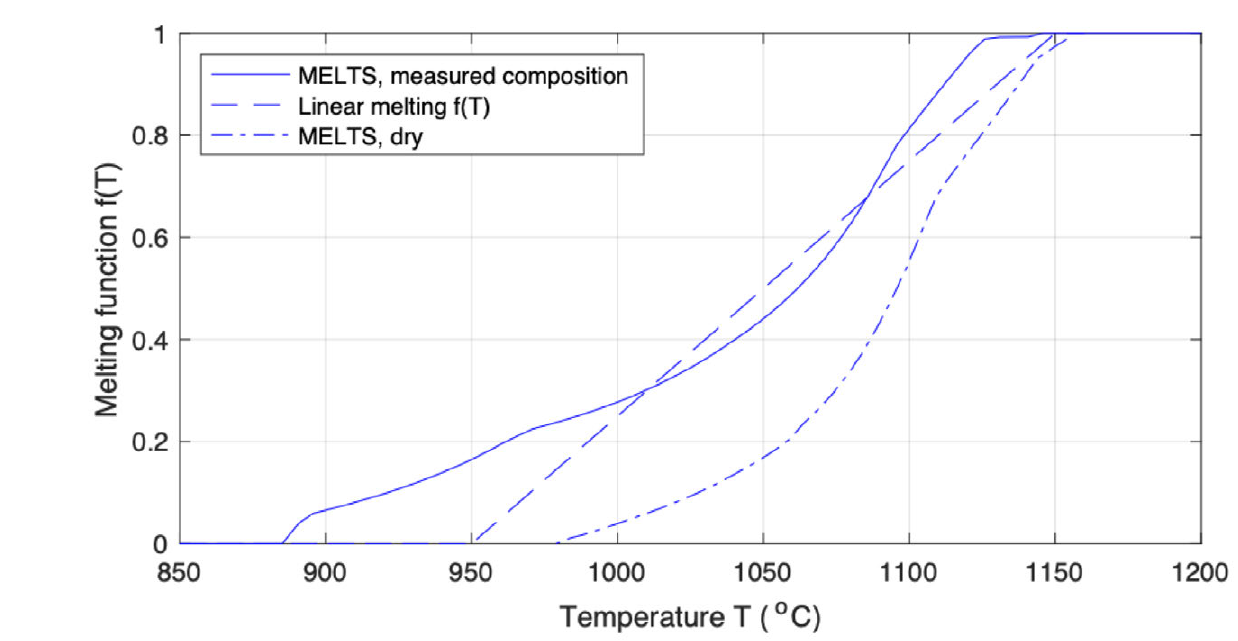
Figure D1: Melting functions versus temperature. Most models use the linear melting function (dashed line). In order to evaluate the sensitivity to this approximation, we also ran one model with the melting function calculated using MELTS (solid line). This melting function was calculated at a pressure of 300 MPa for the composition specified in Table A1. For comparison, we also show the melting function for the same composition, but without water (dash-dotted line); this melting function was not used in the model runs.